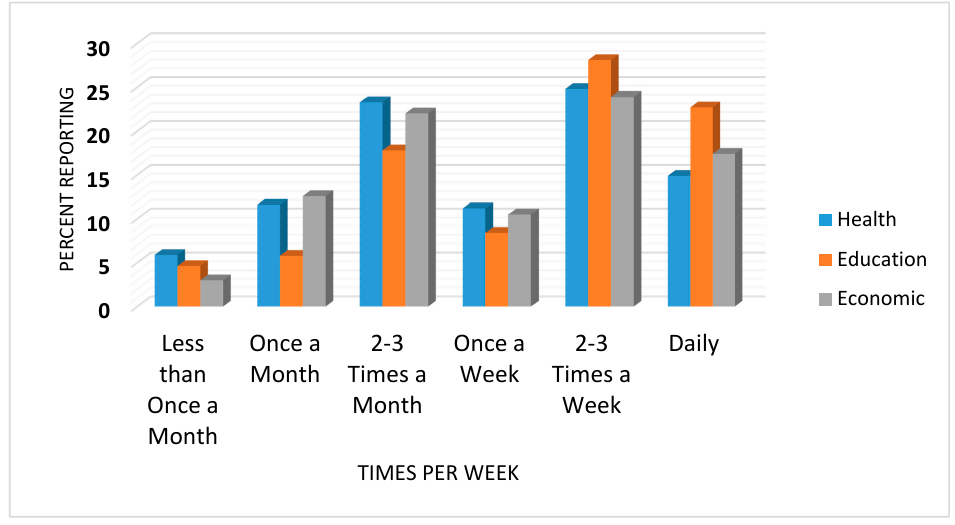
Figure 3. Frequency with which survey respondents would ride the bus for different purposes.